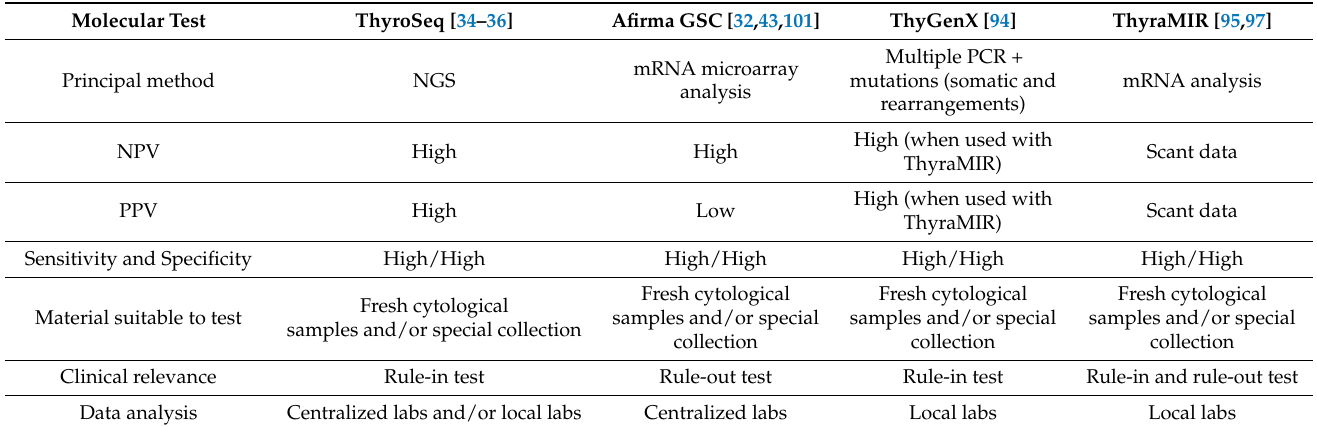
Table 1. Characteristics of different thyroid molecular